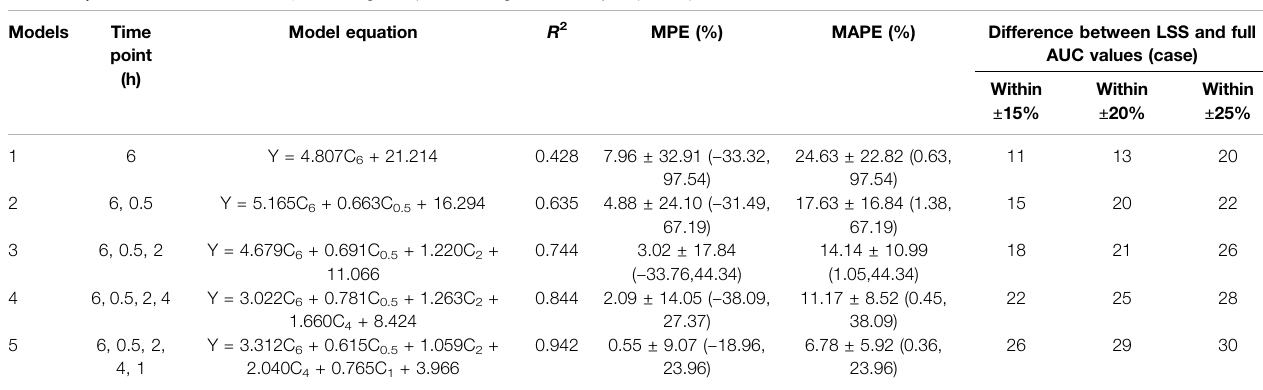
TABLE 4 | LSS models of MPA-AUC 0 – 12 h using multiple linear regression analysis (n (cid:1) 30). Models